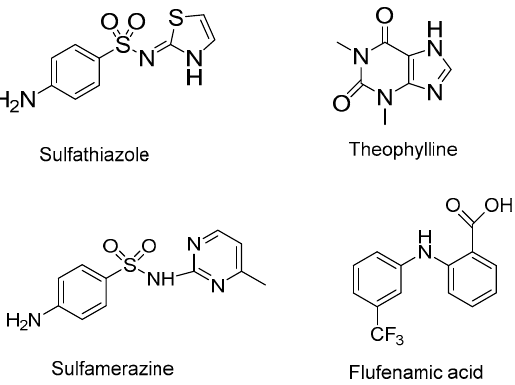
Figure 7. Chemical structures of the APIs chosen for crystallization in gels of G1 .